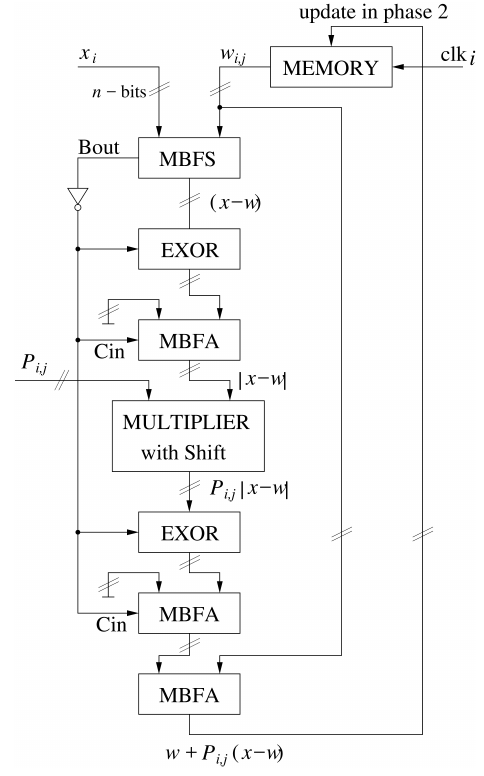
Figure 5. Diagram of the proposed adaptation